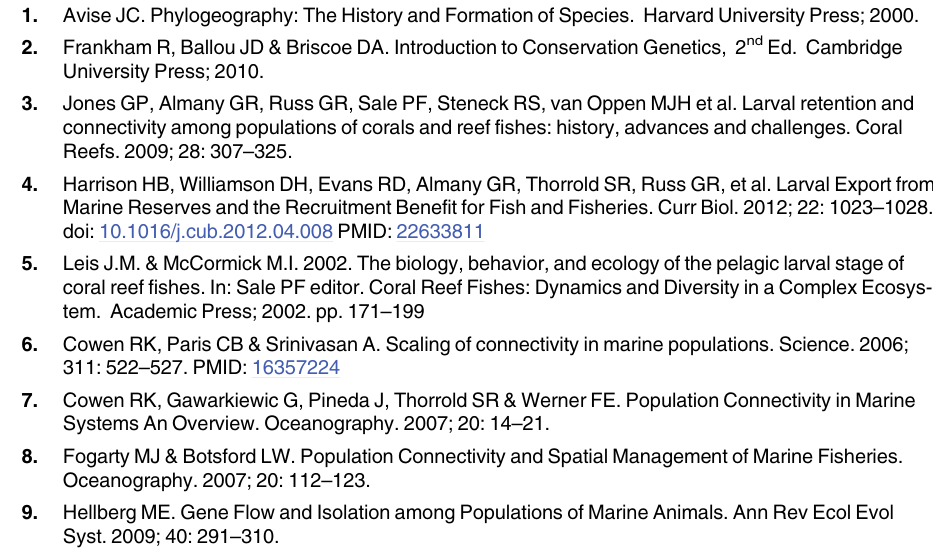
S5 Table. Spatial Autocorrelation analysis for the microsatellite data set excluding putative null alleles. The number of pairwise comparisons, N , correlation, r, upper U and lower L bounds for a 95% confidence interval (H0: r = 0), the upper Ur and lower Lr bounds deter- mined by bootstrap resampling, the probability P of a one-tailed test for positive autocorrela- tion, and the x-intercept are shown across all distance classes. S6 Table. Meta-analysis data including each study used, the FST slope calculated as β ¼ Δ F ST and the spatial pattern identi fi ed in each study. Δ Distance based on meta-analysis S7 Table. Distance predictions according to F ST